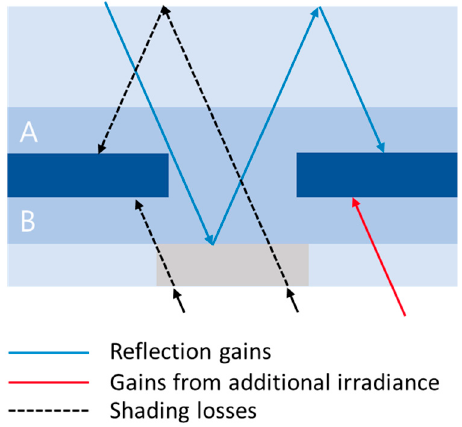
Figure 2. Different exemplary contributions of meshed backsheet on optical gains and losses in PV modules.